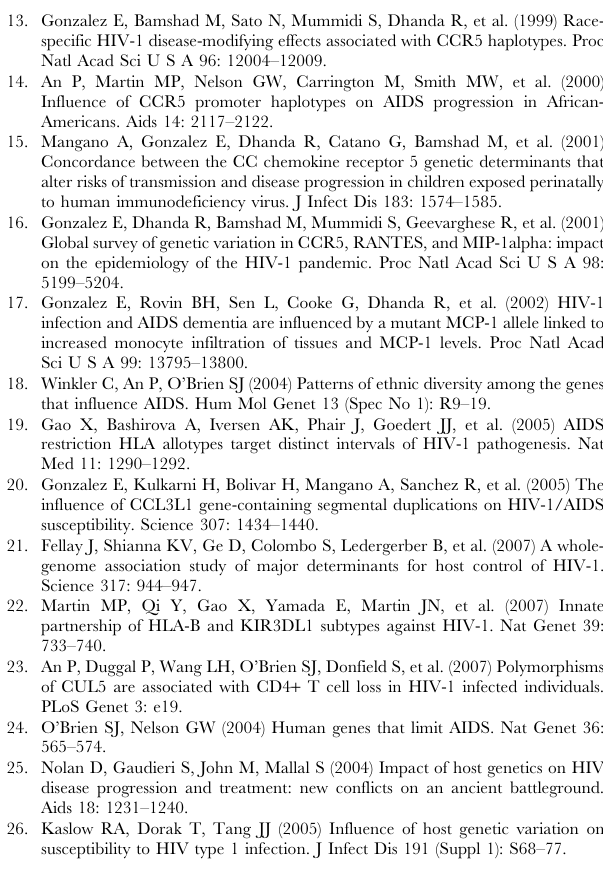
Table S2 Group, indicates subdivision of the population into 9 groups based on their GRGs (Figure 2a). Estimated frequency indicates the proportion of the population groups from data derived from the WHMC cohort. The parameters are described in Supplementary Table